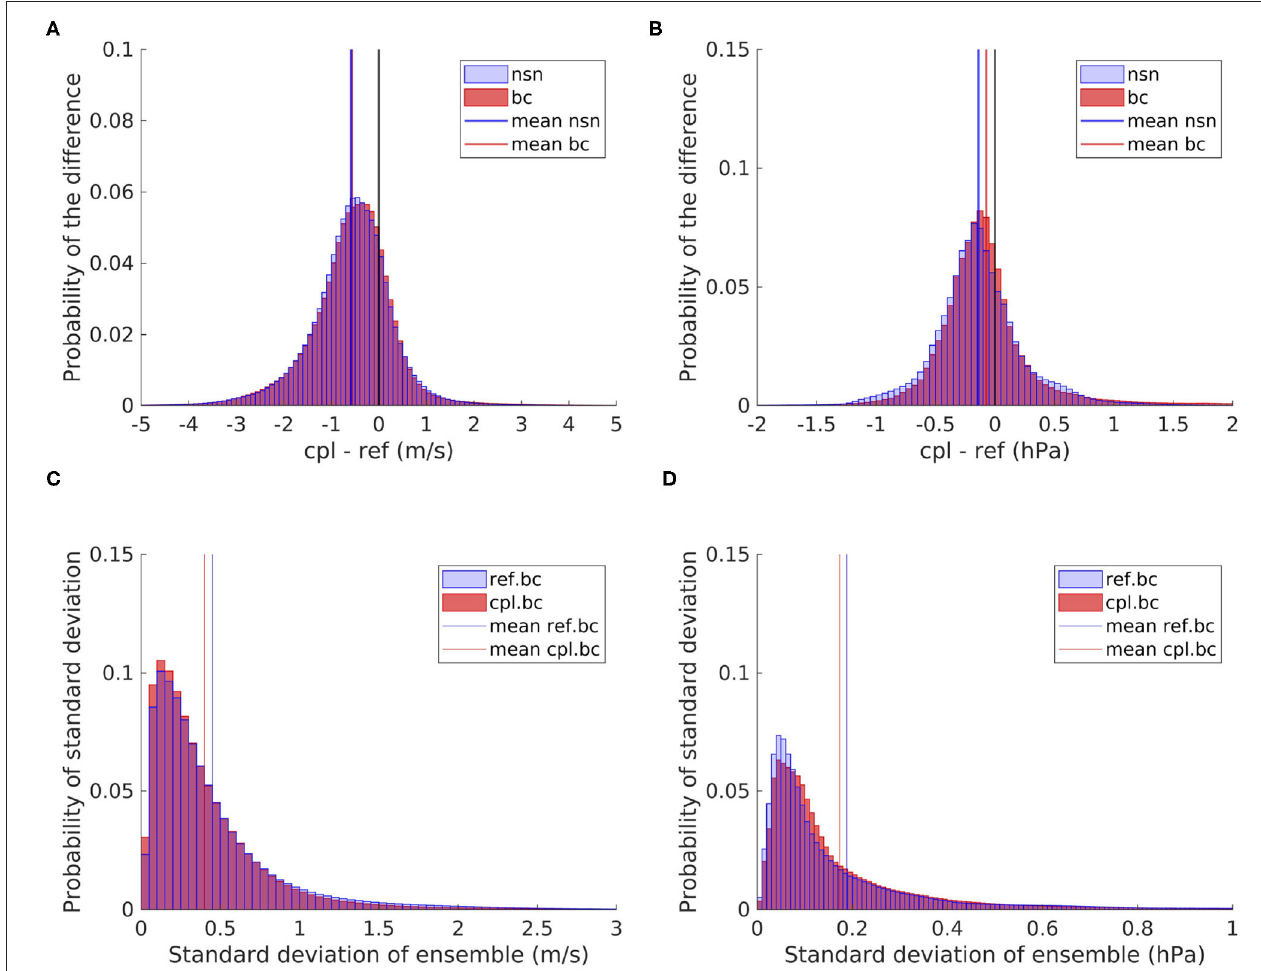
FIGURE 10 | Histogram of the differences between the coupled and reference ensembles in the wind speed (A) and MSLP (B) within the North Sea, as well as the standard deviation of the reference and coupled ensembles within the North Sea area for the wind speed (C) and MSLP (D) .